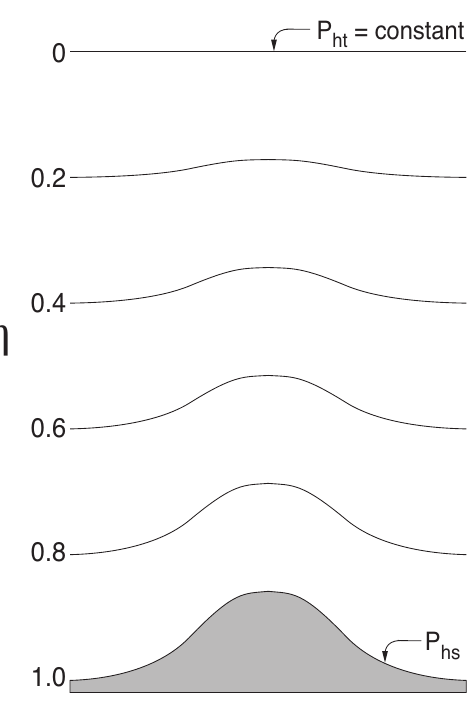
Figure 2.1: ARW η